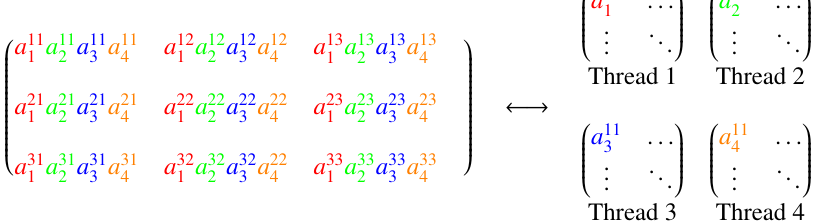
Figure 1. Complex SU(3) on NVIDIA GTX 1080 for implementations with Ope- nACC, CUDA and Jitify.